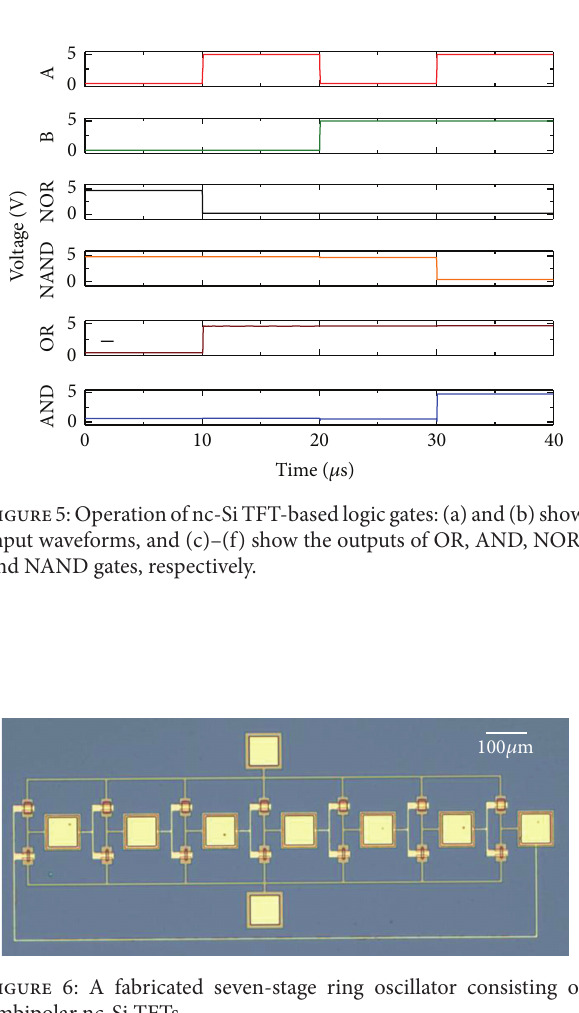
Figure 7: (a) Operation of a three-stage ring oscillator at 𝑉 Waveforms at the output of each stage are shown. The oscillation frequency is approximately 21kHz. (b) Operation of a five-stage ring = 5 V. The oscillation frequency is approximately oscillator at 𝑉 DD